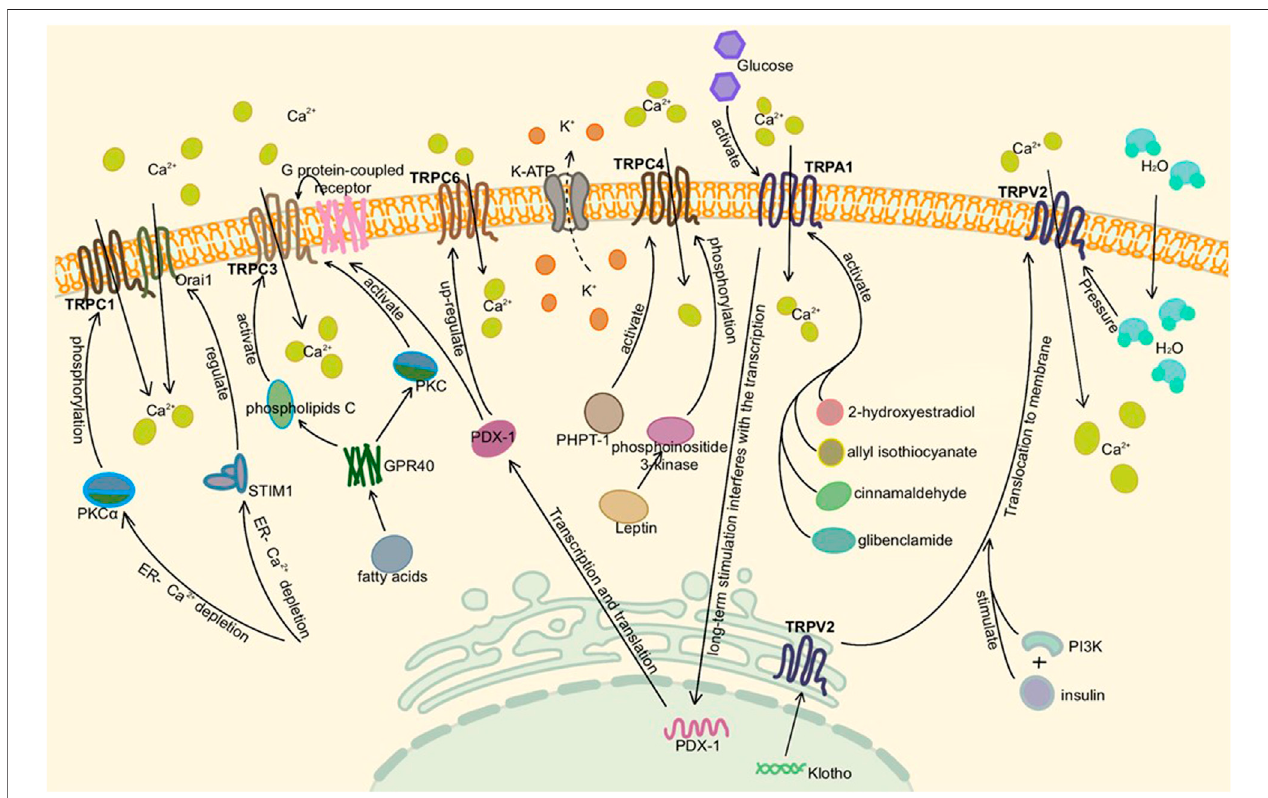
FIGURE 2 | Activation of TRP channels in the pancreas. Here is pancreatic β cell or adenoma cell. TRPC1, TRPC3, TRPC4, and TRPA1 are activated by different pathways, mediating extracellular Ca 2+ in fl ux in the presence of Ca 2+ de fi ciency in the ER and depolarizing to stimulate insulin secretion. TRPC6 is associated with cell proliferation and tumor migration. TRPV2, which existed on vesicles and ER, was activated by insulin synthesis or altered intracellular and extracellular osmotic pressure under high glucose conditions, translocated to the plasma membrane and increased Ca 2+ in fl ux.